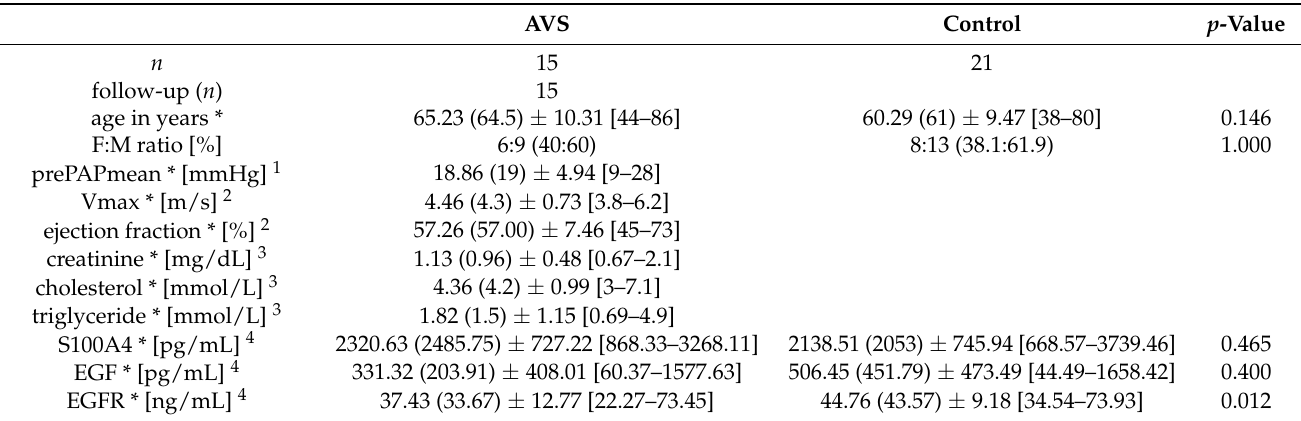
Table 3. Basic demographic and hemodynamic data of AVS patients. Several serum parameters of AVS patients are shown. Concentrations of EndMT biomarkers in AVS patients and healthy controls are reported. Controls were age- and